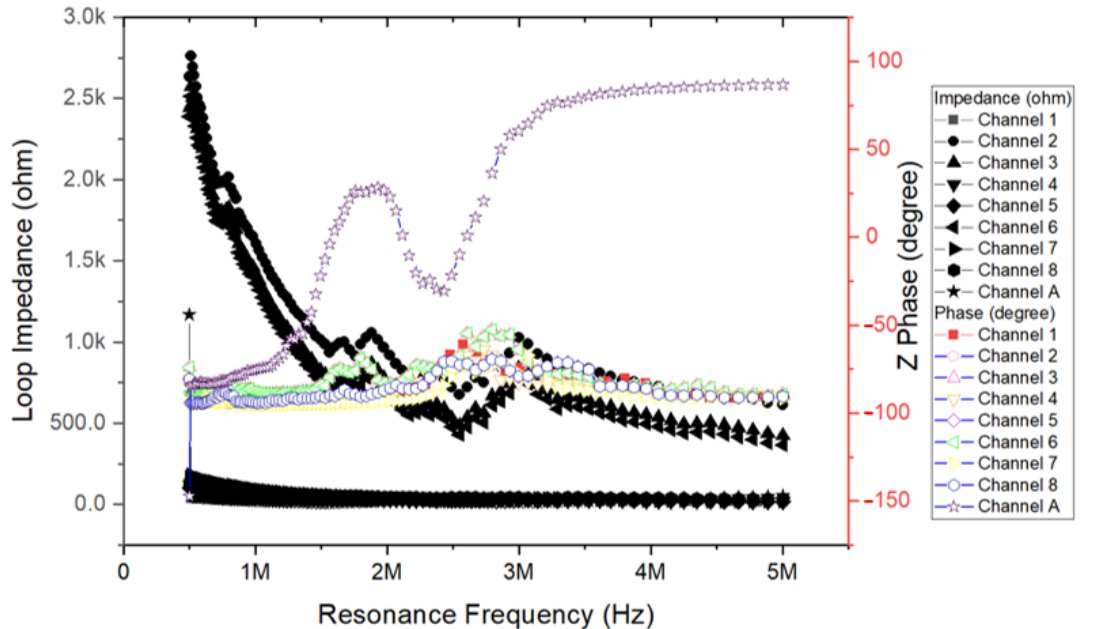
Figure 7. Impedance Z phase frequency conditions between Channels 1–8 and Channel A.